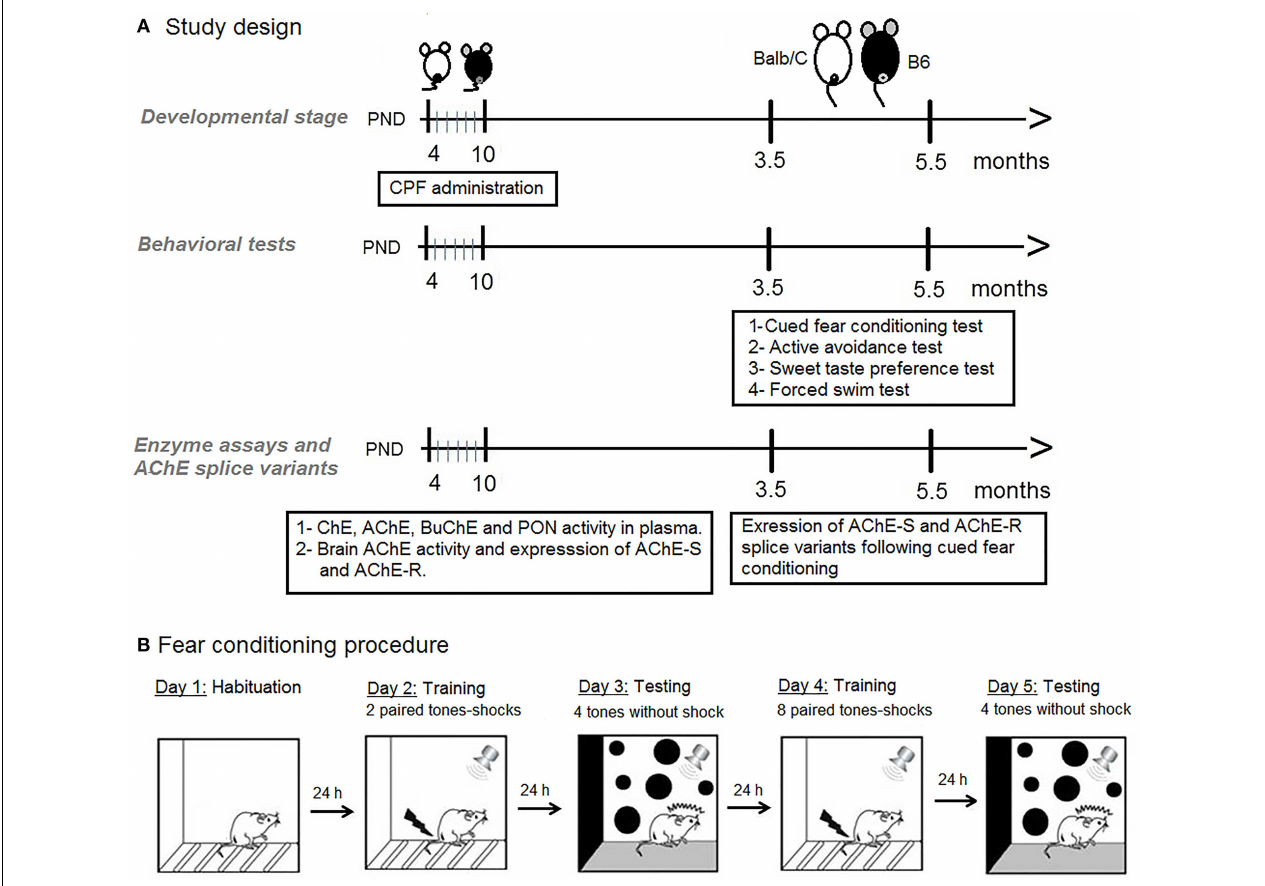
FIGURE 1 | (A) Schematic diagram of the study design. (B) Schematic presentation of the fear conditioning